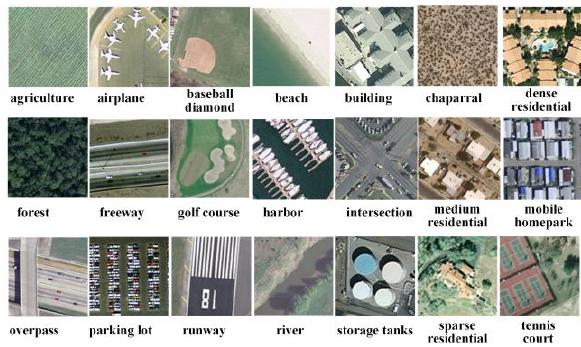
Figure 6. Examples of each class in the target dataset